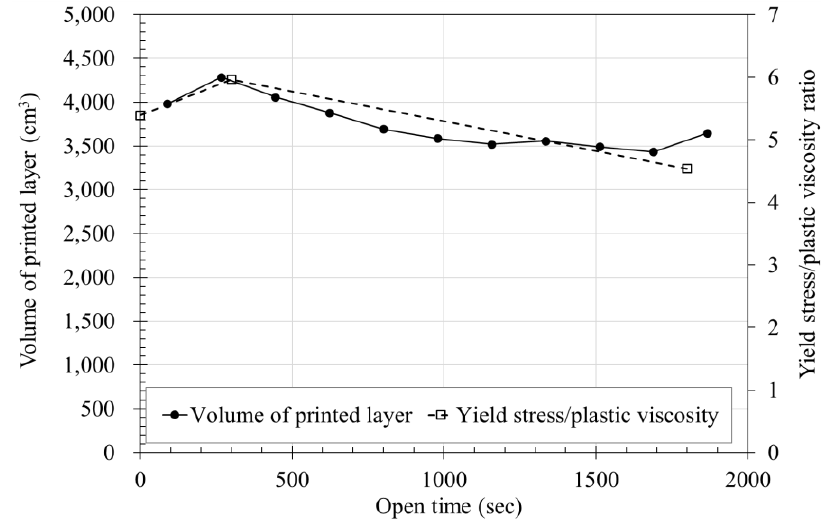
Figure 15. Volume and yield stress/plastic viscosity ratio of printed layers over time.